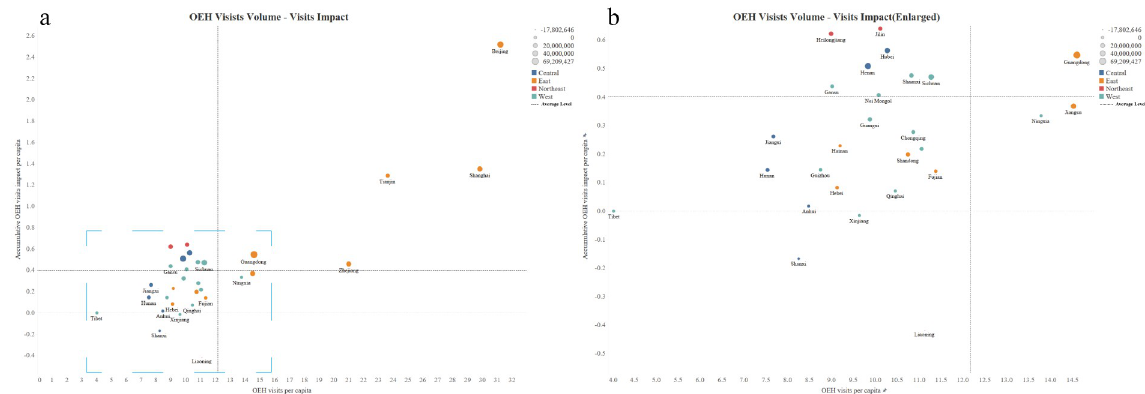
Fig 4. Pre-pandemic OEH visits per capita and its corresponding accumulative impacts of COVID-19 for different provinces. (a) The scatter diagram shows the association between the volume of OEH visits per capita before the pandemic and absolute accumulative impacts on OEH visits per capita for each province. The horizontal axis measures the sum of OEH visits per capita from January 2016 to November 2019, while the vertical axis measures the total loss of OEH visits per capita from February 2020 to March 2021. The horizontal and vertical gray dotted lines respectively show the average loss of visits per capita and average visits per capita nationwide. One dot represents one province. The same color means belonging to the same region. The size of each dot represents the total loss of OEH visits per capita. (b) This panel is an enlarged view of the part labeled by the blue dashed square in Panel